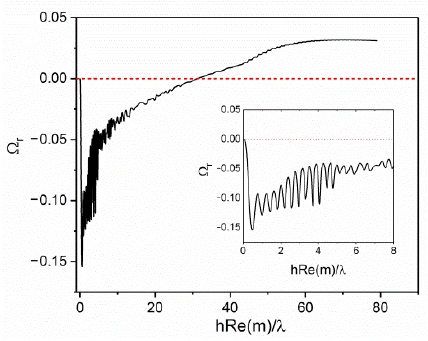
Figure 10. Dependence of Ω r on crystal thickness at constant absorption μ − 1 = 10 µm for λ = 400 nm.